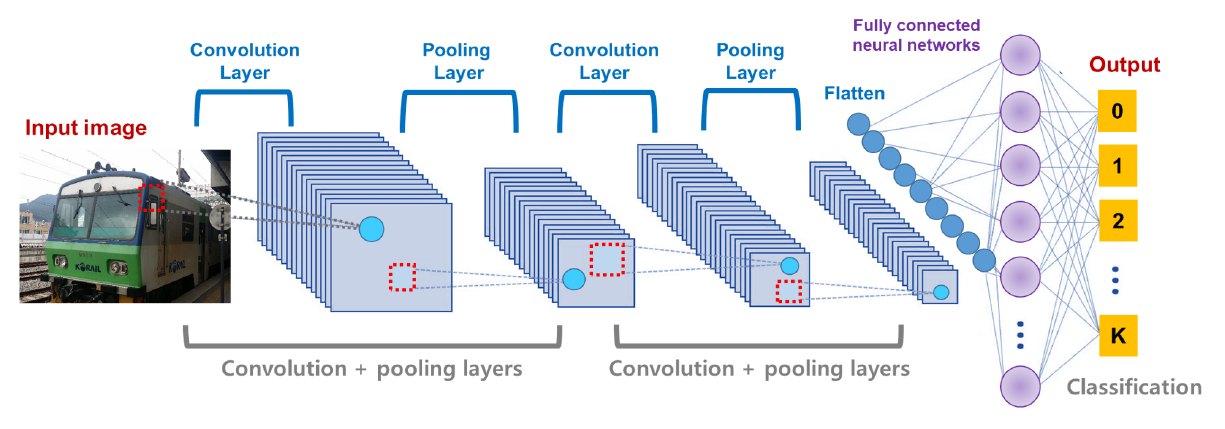
Figure 1. The overall architecture of